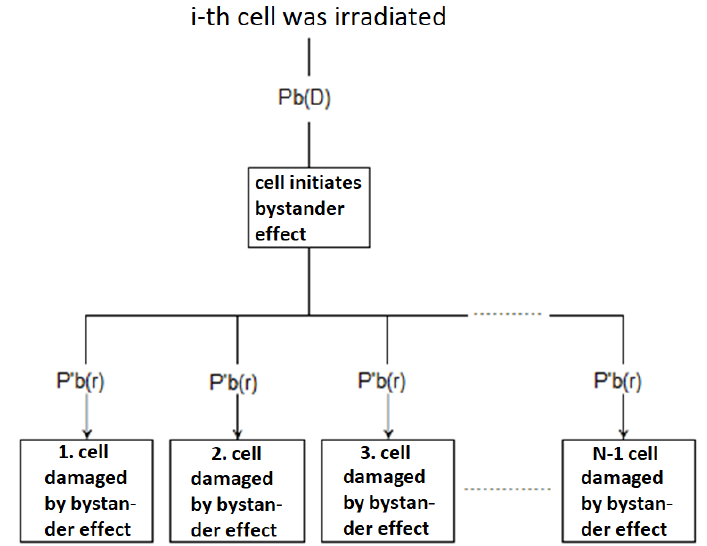
Figure 1. Block diagram of the bystander effect algorithm used in a program simulating the response of a group of cells to ionizing radiation using the Monte Carlo method [26]. The presented probability functions are given by Equations (35) and (36).